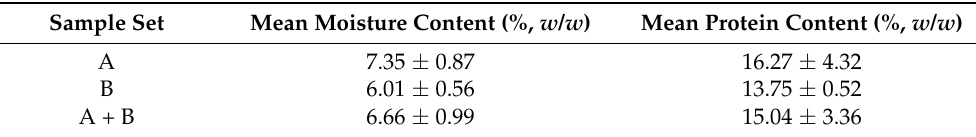
Table 2. Mean moisture content (w.b.) and protein content of two sample sets.